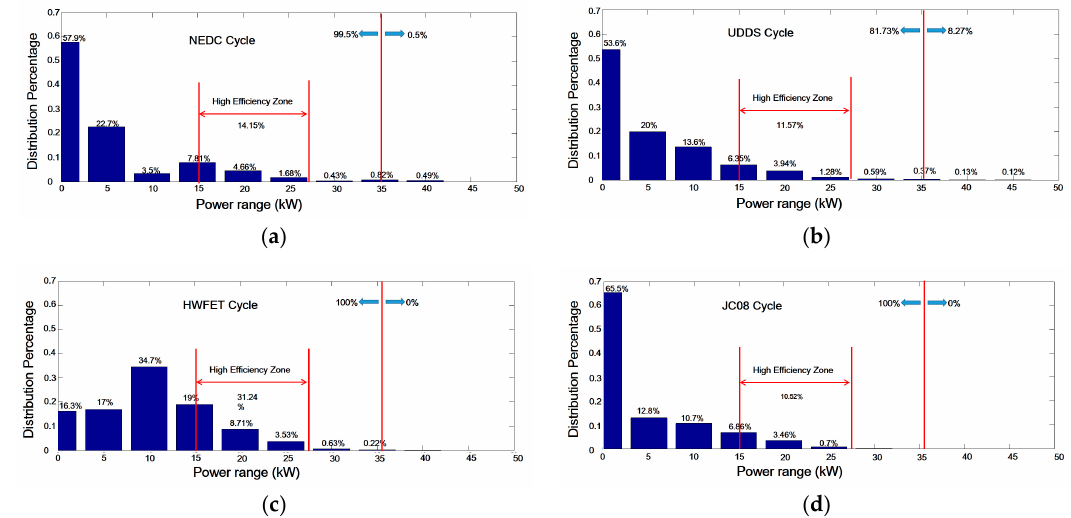
Figure 10. ( a ) Histogram of the requested traction motor output power distribution in NEDC cycle; ( b ) Histogram of the requested traction motor output power distribution in UDDS cycle; ( c ) Histogram of the requested traction motor output power distribution in HWFET cycle; ( d ) Histogram of the requested traction motor output power distribution in JC08 cycle;